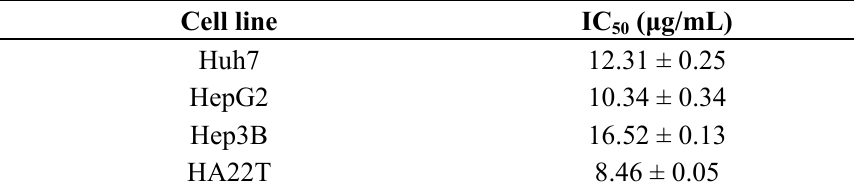
Table 1. IC50 values of sinulariolide treatment in four HCC cell